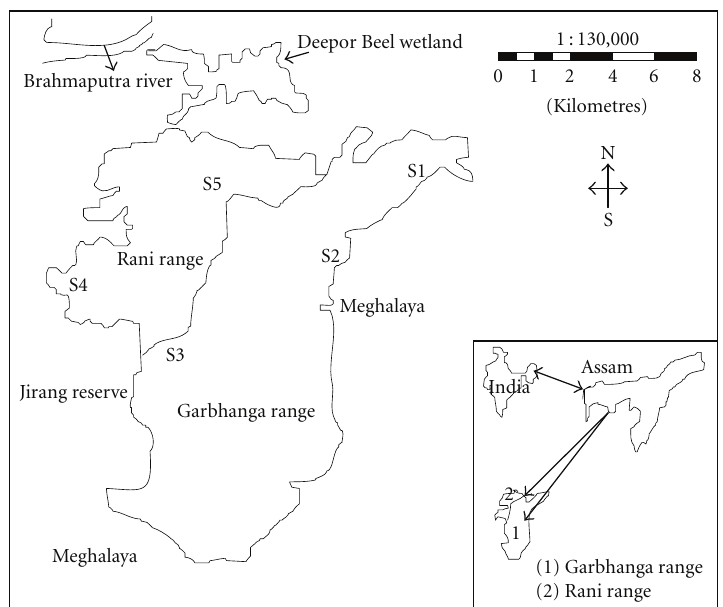
Figure 1: Map of Rani-Garbhanga Reserve forest in Assam, Northeast India.